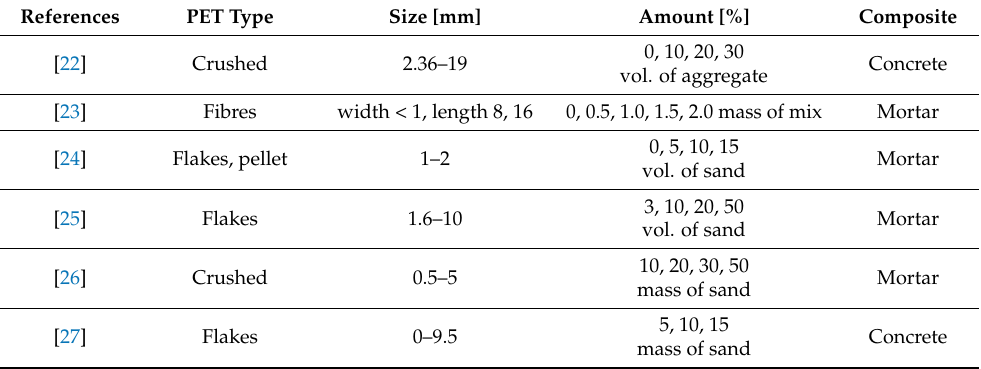
Table 1. The use of PET particles in cementitious composites.